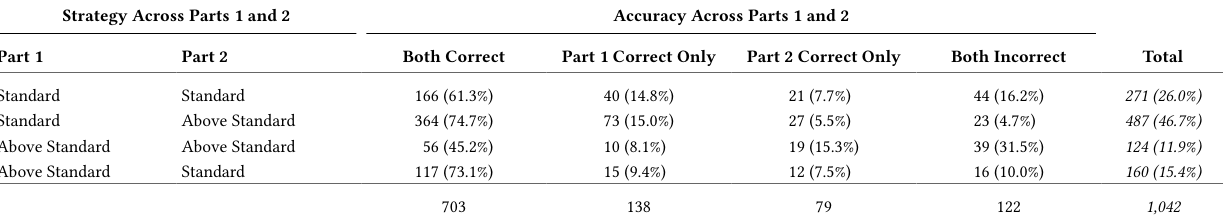
Frequency Counts for Patterns of Accuracy and Strategy Across Parts 1 and 2 Strategy Across Parts 1 and